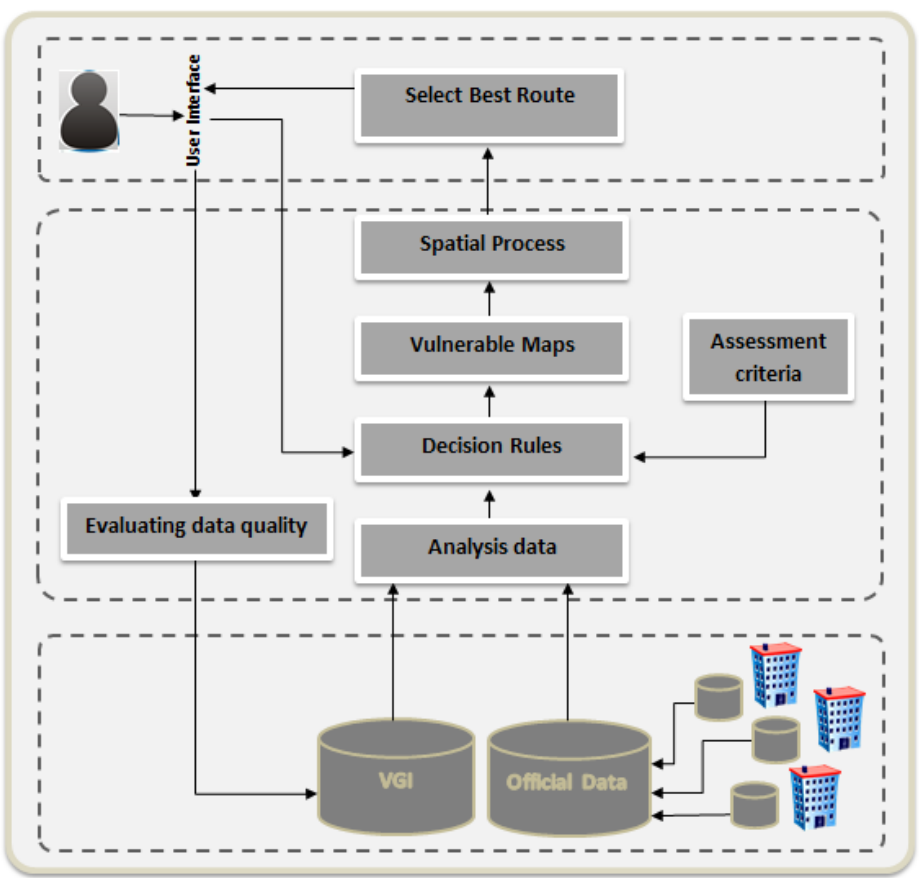
Figure 3. User involvement and coordination between different organizations for selecting the best route